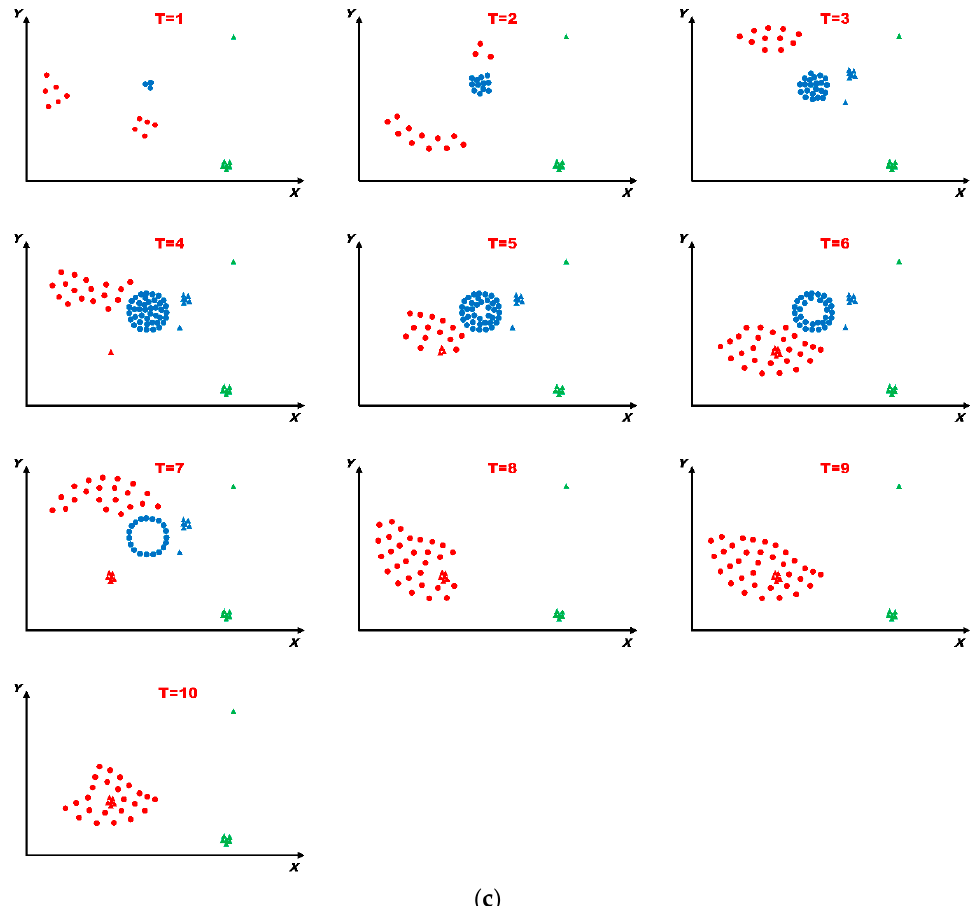
Figure 2. A simulated dataset of spatio-temporal point events with 10 time stamps. ( a ) spatio-temporal distribution of the dataset viewed from four different perspectives; ( b ) spatial projection of spatio-temporal point events for all time stamps; ( c ) spatial projection of spatio-temporal point events for individual time stamps.